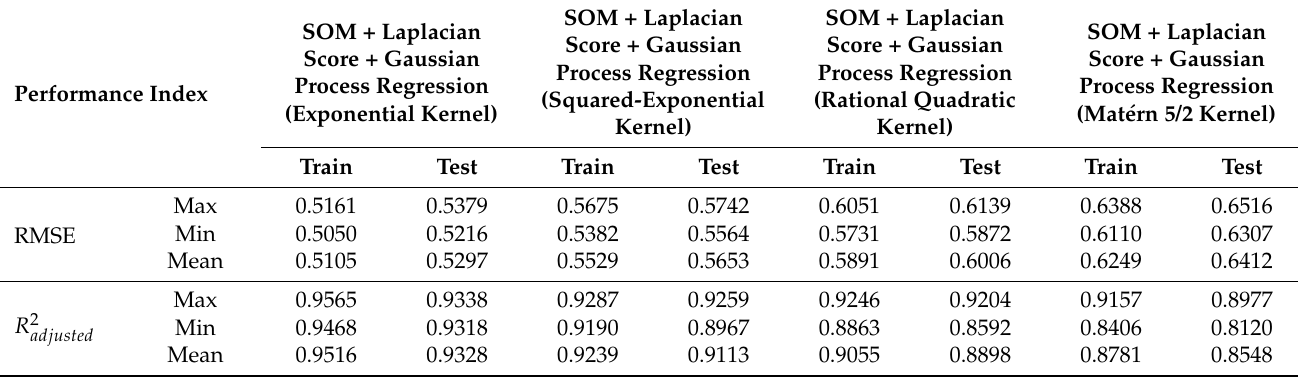
Table 5. Adjusted R 2 and RMSE results for